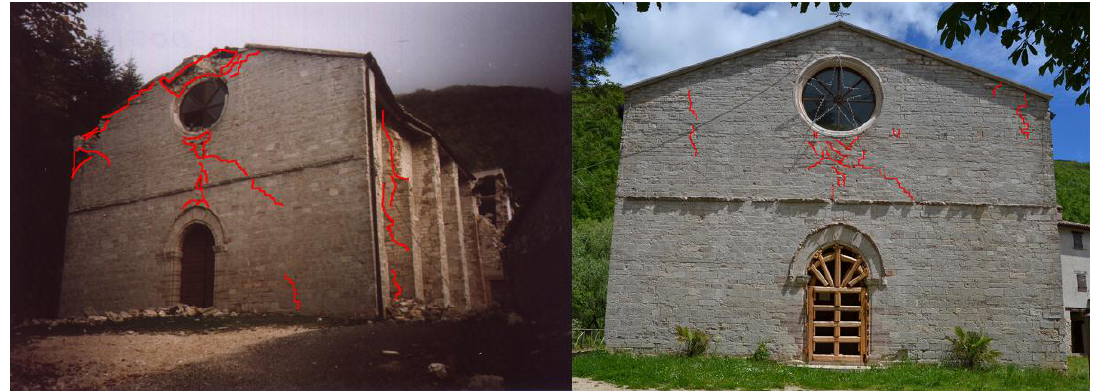
Figure 21. Comparison of the state of damage on the façade after the 1997 earthquake (on the left) and the 2016 one (on the right).